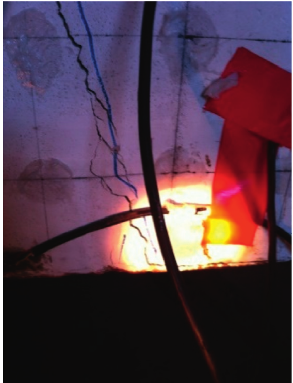
Figure 10: Cracks and gap at the connection